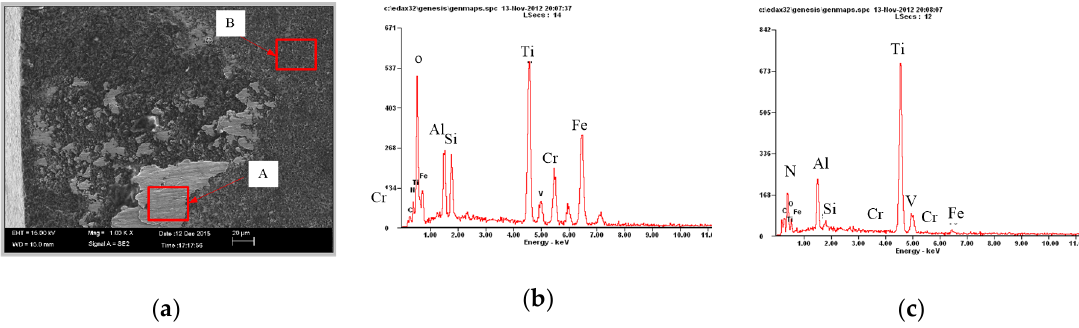
Figure 12. PCBN cutting tool flank wear morphology: ( a ) The microstructure of the flank wear; ( b ) Analysis of element content at A; ( c ) Analysis of element content at B.